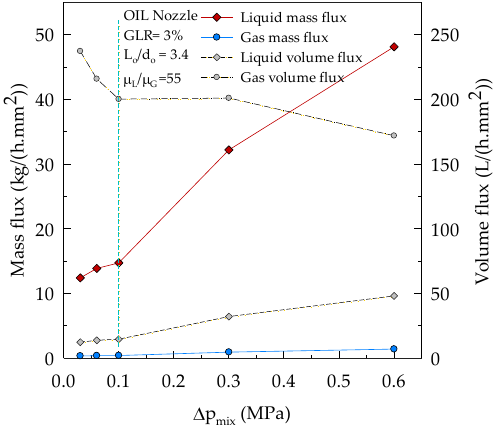
Figure 6. The effect of ∆p mix on the mass and volume fluxes at a constant GLR for the OIG nozzle. Figure 6. The e ff ect of ∆ p mix on the mass and volume fluxes at a constant GLR for the OIG